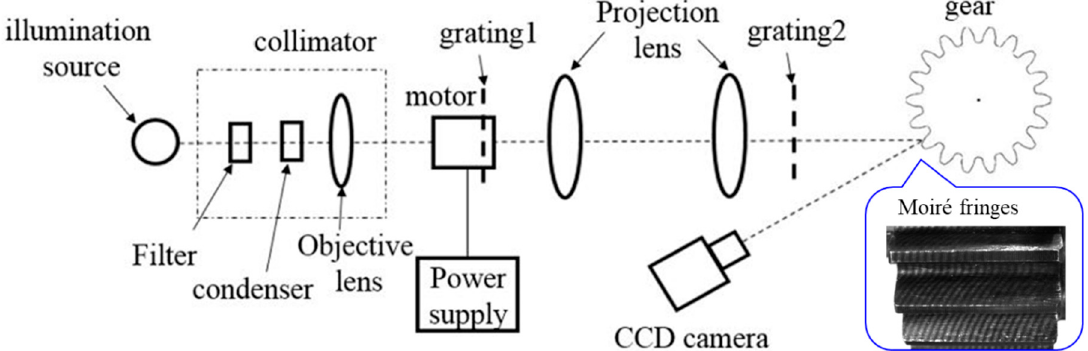
Figure 2. Illustration of the experimental framework of the projection moiré system.